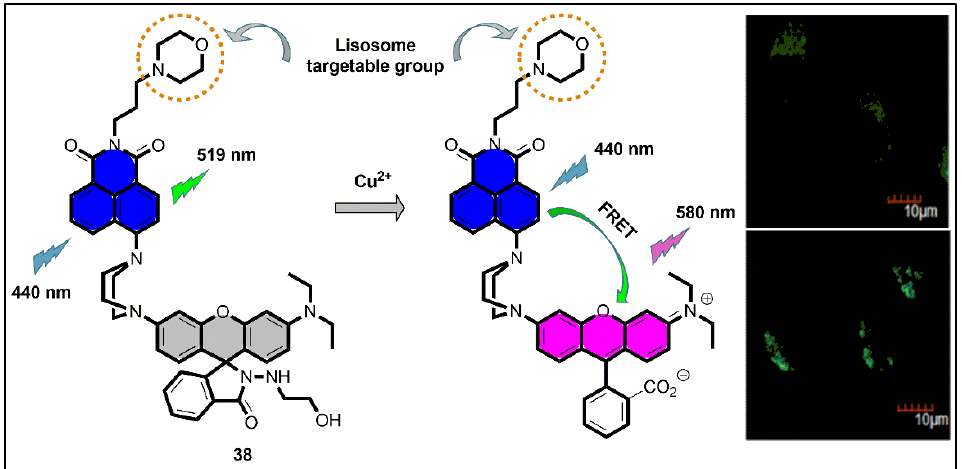
Figure 39. Sensing mechanism of 38 in the presence of Cu 2+ . Fluorescence images of L929 cells with 38 (200 nM) of the green channel ( λ EX = 559 nm; λ EM : 581-620 nm) in the absence (upper panel) and presence (lower panel) of Cu 2+ (1 μM). Adapted with permission from [ 123]. Copyright (2017) The Royal Society of Chemistry.